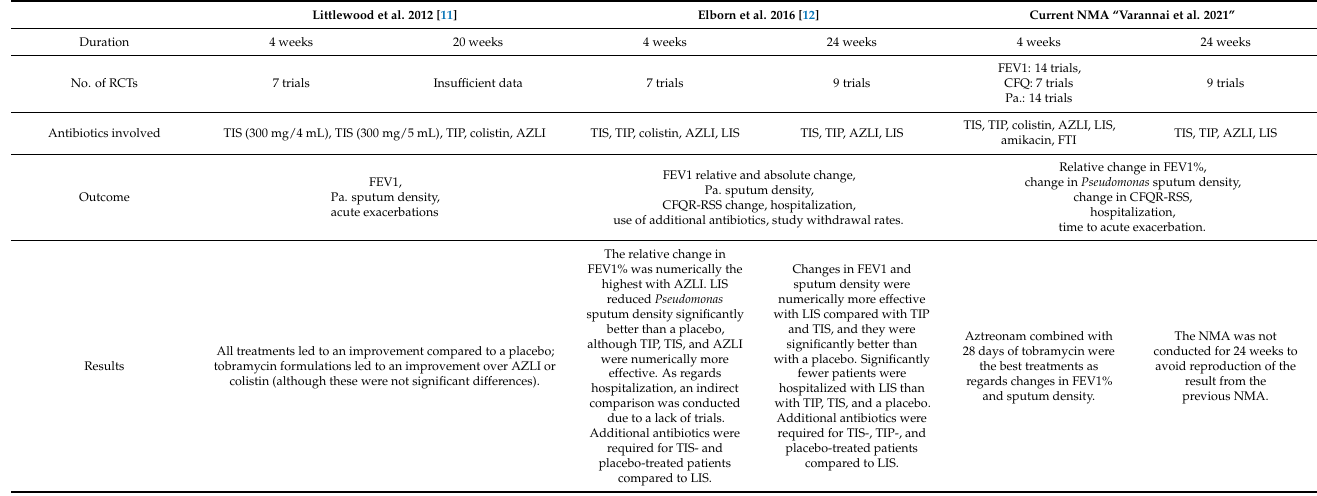
Table 2. Comparison of previous